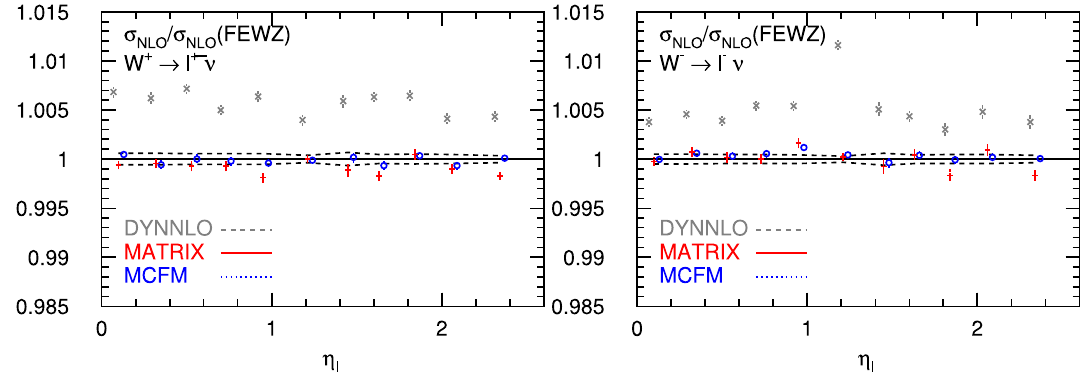
Fig. 1 The NLO QCD cross sections for inclusive pp → W ± + X → and mass are applied as in the ATLAS data selection [6]. The error bars l ± ν + X as function of pseudo-rapidity η l , computed with DYNNLO , indicate the accuracy of the numerical integration, shown by the hori- MATRIX and MCFM relative to FEWZ and using the ABMP16 PDFs. zontal dashed lines for the FEWZ result. The MATRIX result is plotted ≥ 25GeV and M ≥ 40GeV for the transverse momenta inthecenterofeach η l -bin,while DYNNLO and MCFM resultsareshifted Cuts of p l ,ν T T slightly to the left and the